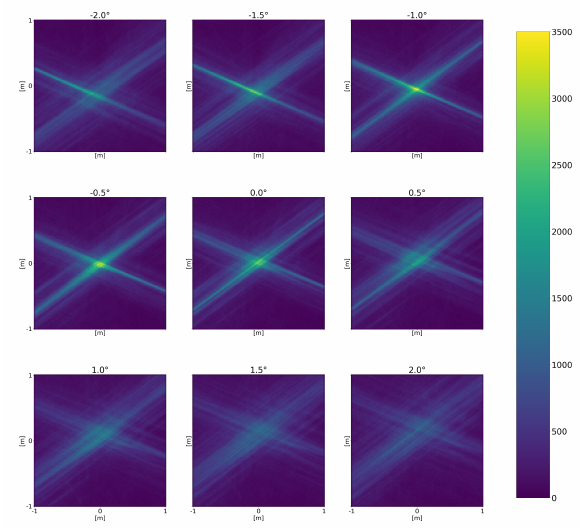
Figure 1. Maximum consensus accumulator for the point cloud depicted in Figure 2. Figure 3. Maximum consensus accumulators for headings from -2 to +2 degrees around the initial heading. heading, the peak gets smaller and more